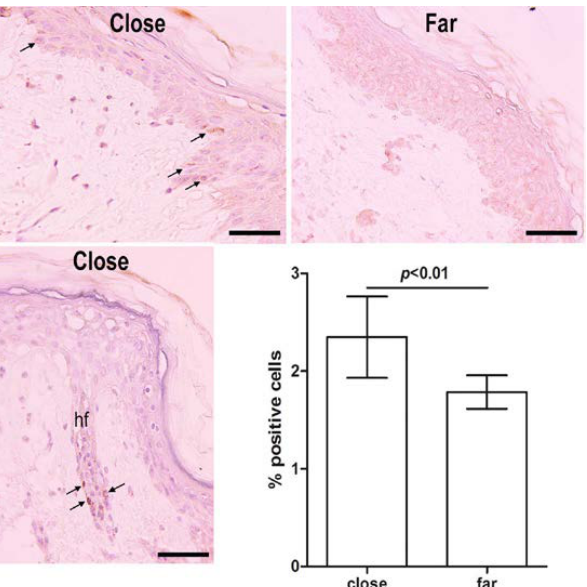
Figure 9. Immunostaining to reveal Ki67-positive proliferating cells in the skin specimens after long-term incubation in enriched medium, freezing and thawing. Positive cells (arrows) were slightly, albeit significantly, more numerous close to the wound than far (3–5 mm) from it. Some of them can be seen in the bulge of a hair follicle (hf). Ki67 immunoperoxidase staining; bars = 100 µm; values are mean ± s.e.m., n = 4, n.s. not significant.